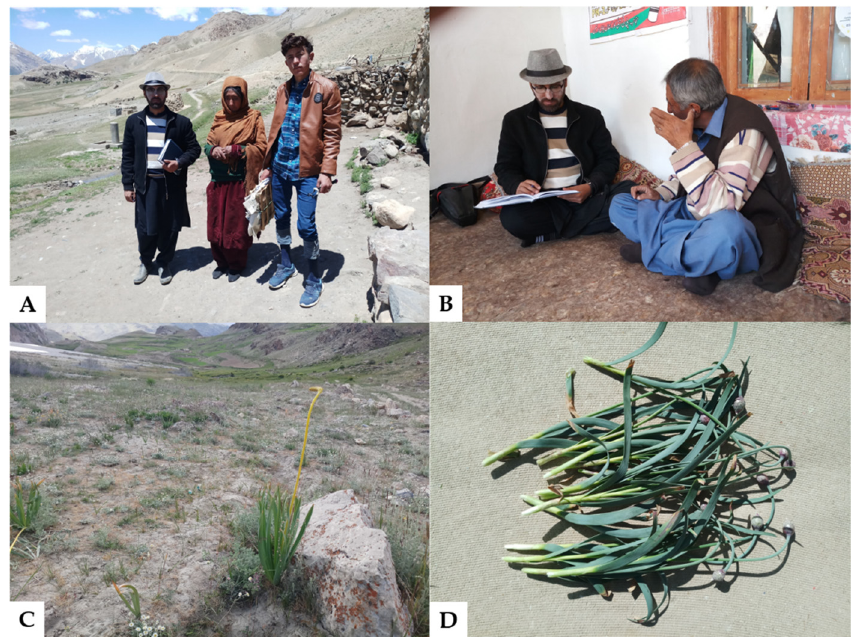
Figure 2. Informants interviewed among the Sarikoli ( A , B ); Photos of Eremurus stenophyllus ( C ) and Allium carolinianum ( D ).